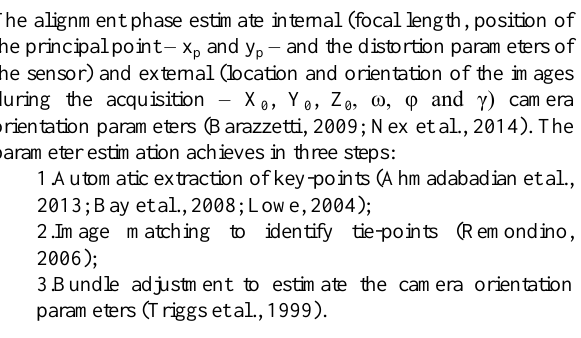
Table 1. Used hardware component and general data of the survey and photogrammetry